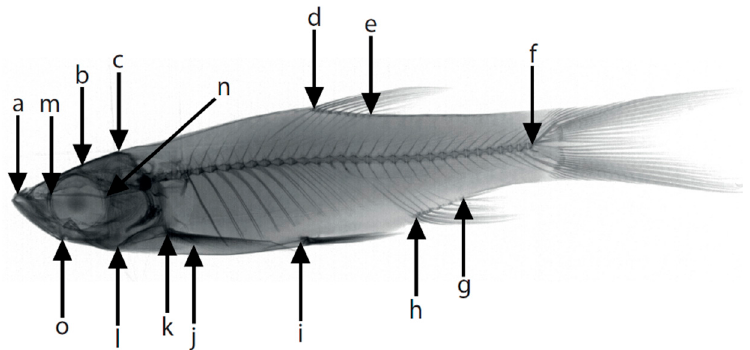
Figure 1. Fifteen homologous landmarks (black arrows) were placed on characteristic points describing the shape of each individual. ( a ) anterior tip of premaxilla, ( b ) dorsal neurocranium process, ( c ) posterior dorsal point of neurocranium, ( d ) anterior insertion of dorsal fin, ( e ) posterior insertion of dorsal fin, ( f ) posterior tip of last vertebrae, ( g ) posterior insertion of anal fin, ( h ) anterior insertion of anal fin, ( i ) anterior insertion of pelvic fin, ( j ) posterior insertion of pectoral fin, ( k ) anterior insertion of pectoral fin, ( l ) preopercular corner, ( m ) anterior ventral point of eye socket, ( n ) posterior ventral point of eye socket, and ( o ) posterior ventral end of articular.